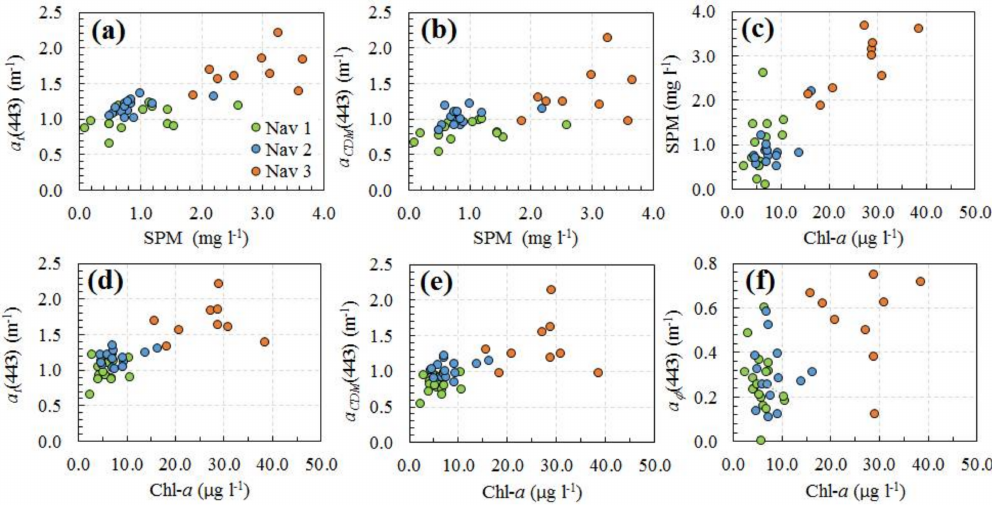
Figure 8. Relationship between optical properties and water quality parameters: ( a ) a t ( 443 ) versus SPM; ( b ) a CDM ( 443 ) versus SPM; ( c ) a φ ( 443 ) versus SPM; ( d ) a t ( 443 ) versus Chl- a ; ( e ) a CDM ( 443 ) versus Chl- a , and ( f ) a φ ( 443 ) versus Chl- a